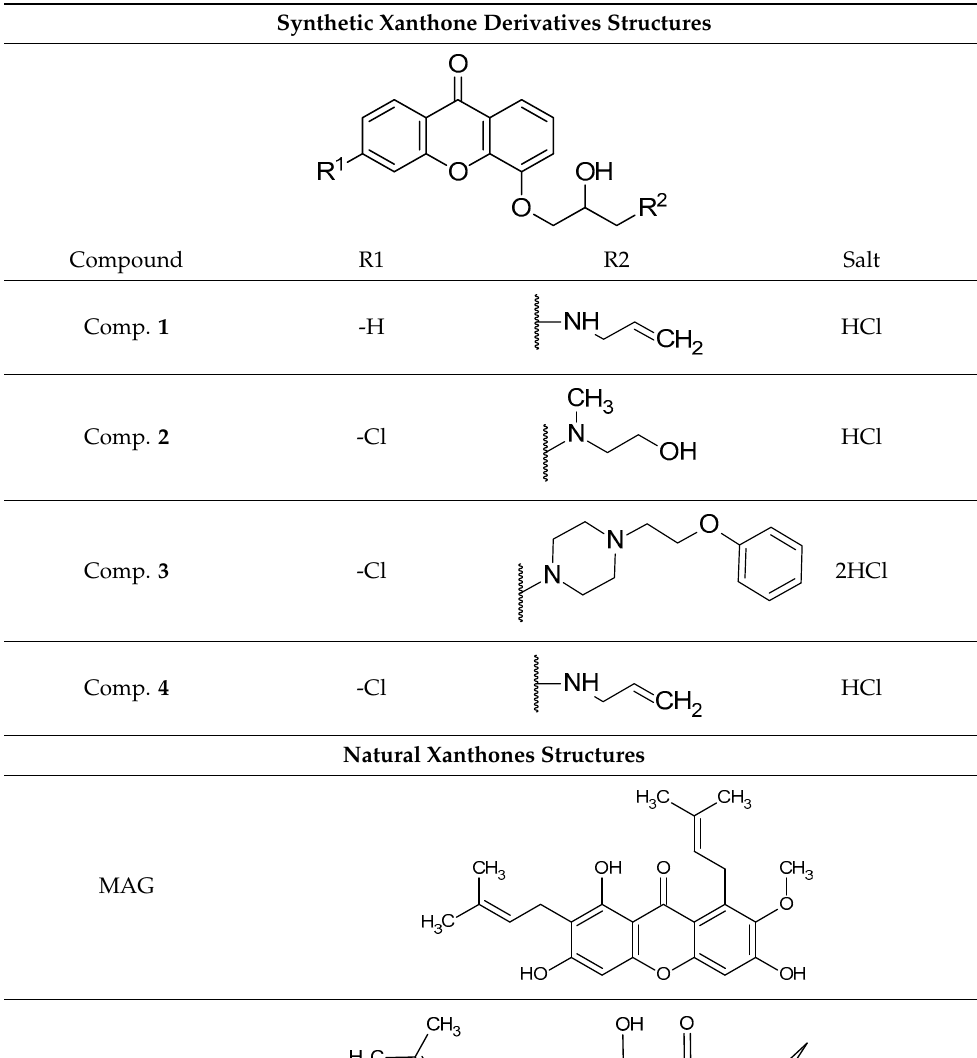
Table 1. Chemical structure of synthetic derivatives and natural xanthones evaluated in this study.